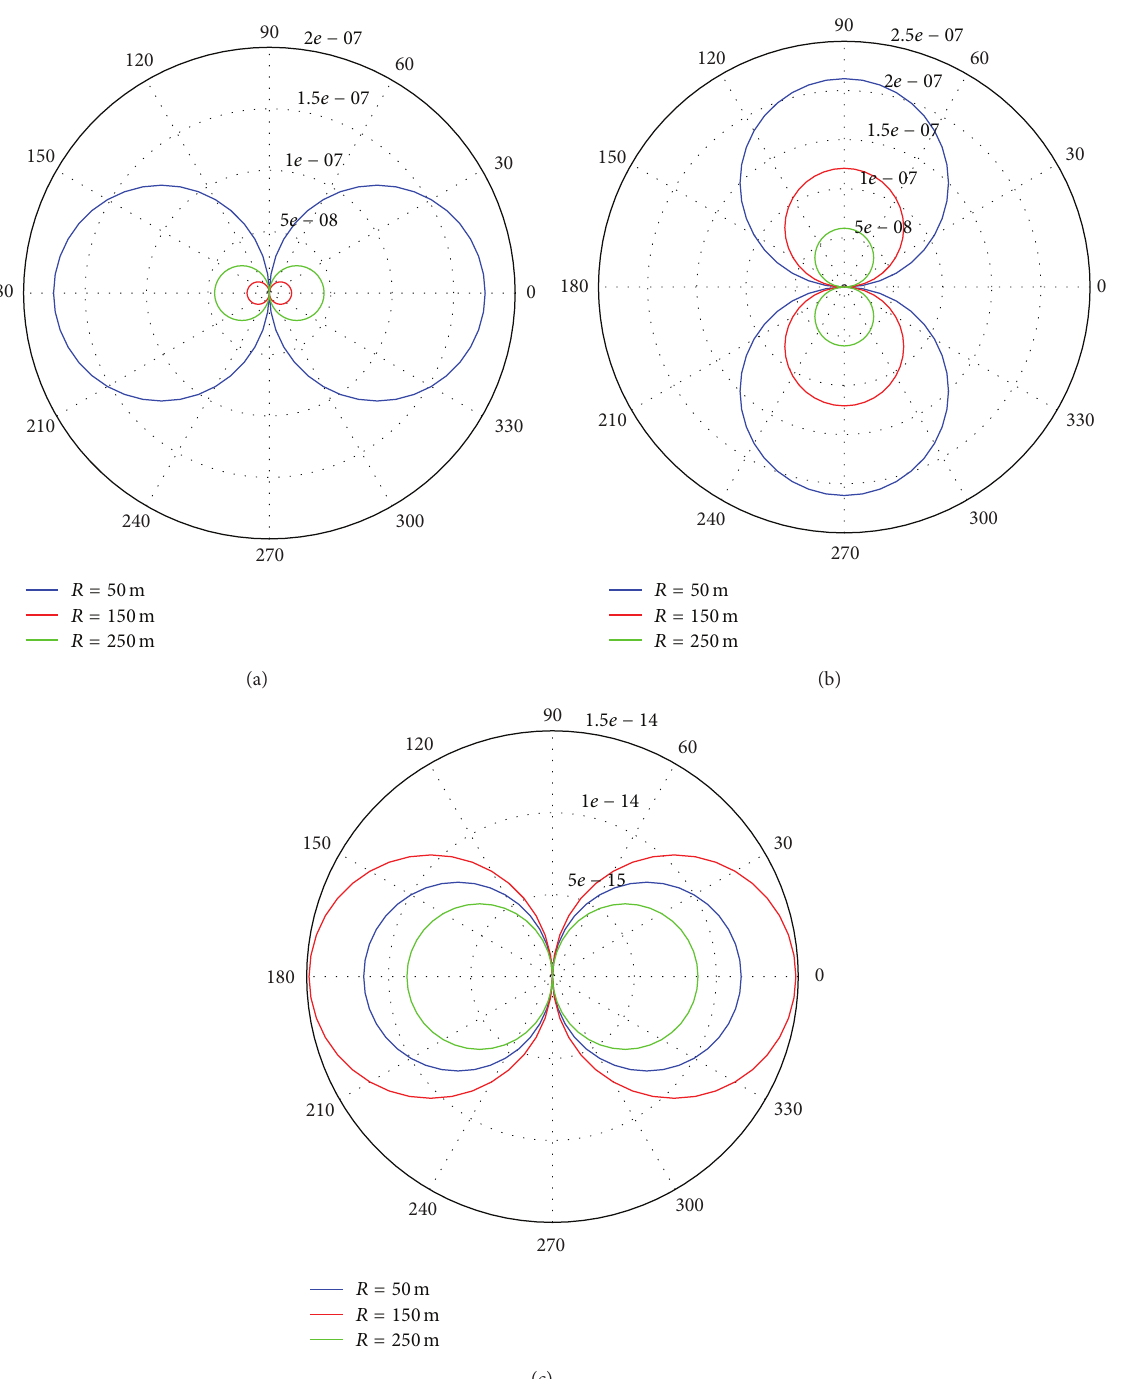
Figure 4: Curves of (a) the radial component of the electric field magnitude, (b) the tangential component of the electric field magnitude, and (c) the axial component of the electric field magnitude with the polar angle.